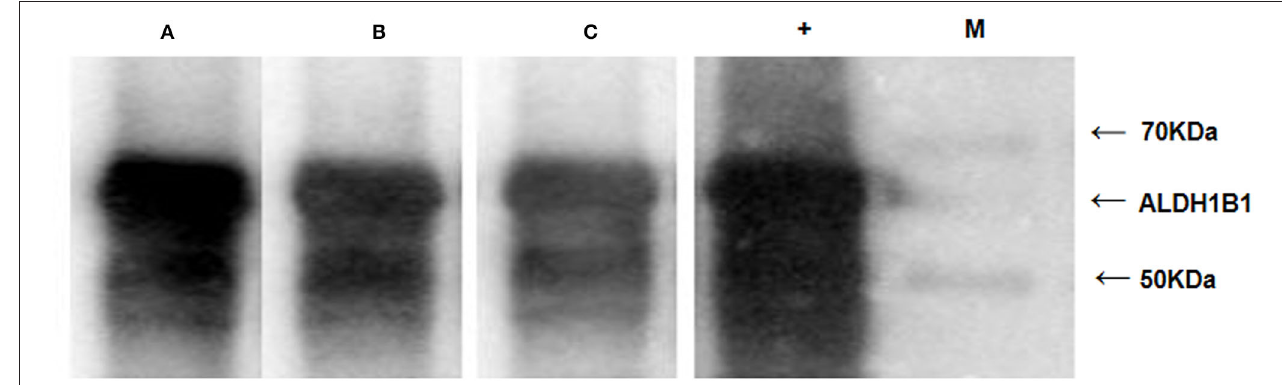
FIGURE 6 | Western blots with recombinant ALDH1B1 protein to detect the serum level of ALDH1B1 autoantibodies. Serum samples were obtained from AA patients (A) , CRC patients (B) , and healthy controls (C) . The lane with “ + ” indicates an antibody against ALDH1B1 used as a positive control; M. EasySee Western Marker (TransGen Biotech,